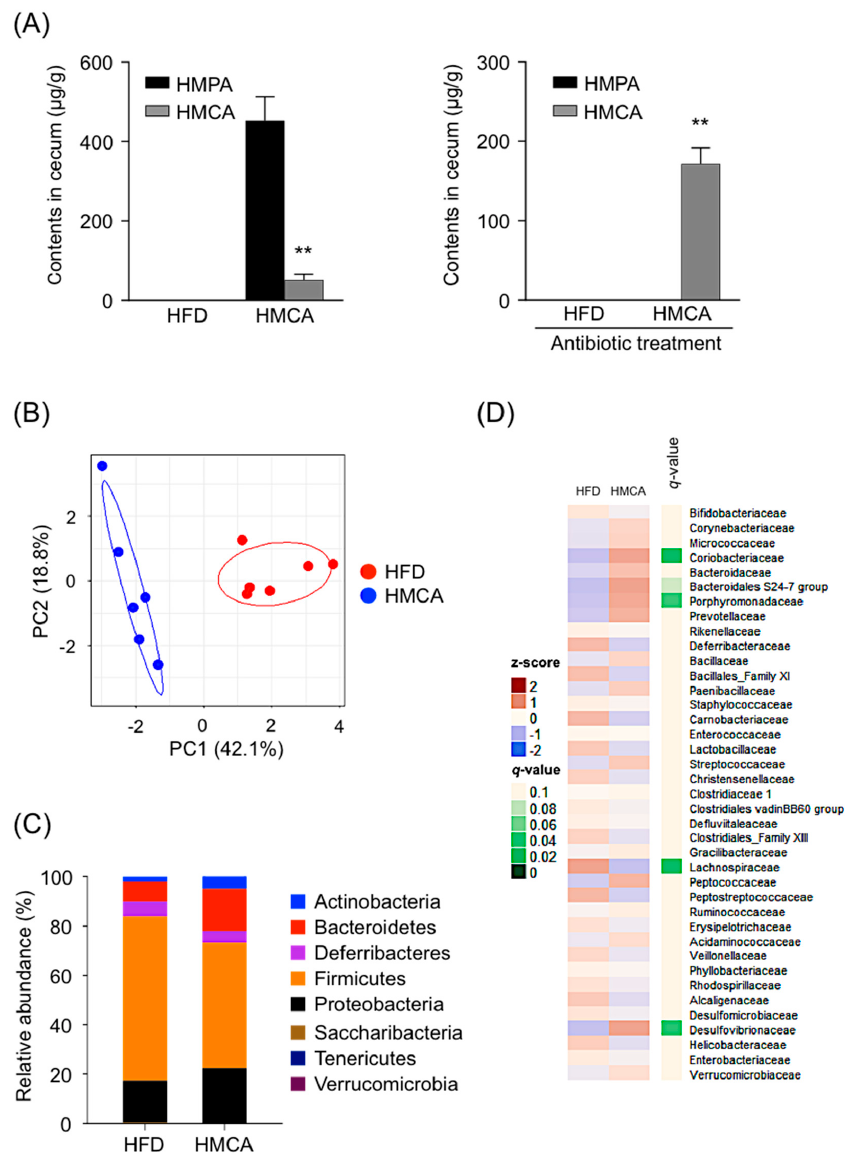
Figure 2. Conversion of HMCA into HMPA by gut microbiota. ( A ) Mice treated with/without antibiotics were fed HFD containing HMCA for one week. After feeding, the cecal contents of HMCA and HMPA were determined ( n = 6–8, left; conventional condition, right; antibiotic treatment). ( B – D ) Changes in the gut microbiome in the HMCA-supplemented HFD-fed mice for 12 weeks. (B) Principal coordinate analysis (PCoA) of the cecal microbiota in HMCA-supplemented HFD-fed vs. the HFD-fed mice based on unweighted Unifrac distances between diet treatments ( n = 6). ( C ) Relative abundance of the phylum level ( n = 6). ( D ) Heatmap of relative abundance of major taxonomic groups at family level (mean relative abundance >0.1%) in HMCA-supplemented HFD-fed mice vs. the HFD-fed control mice ( n = 6). FDR, q <0.1. All data are presented as the means ± SEM. Differences were assessed by Student’s t -test. Significance is established at adjusted ** p <0.01. HFD: high-fat diet; HMCA: 4-hydroxy-3-methoxycinnamic acid; HMPA: 3-(4-hydroxy-3-methoxyphenyl)propionic